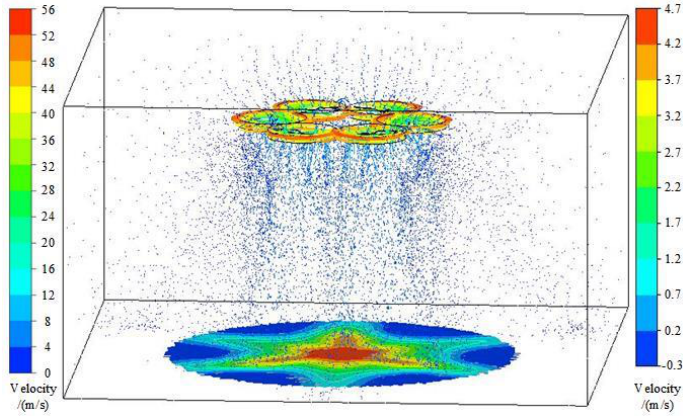
Figure 5. Simulation of the downwash flow field under the rotor.